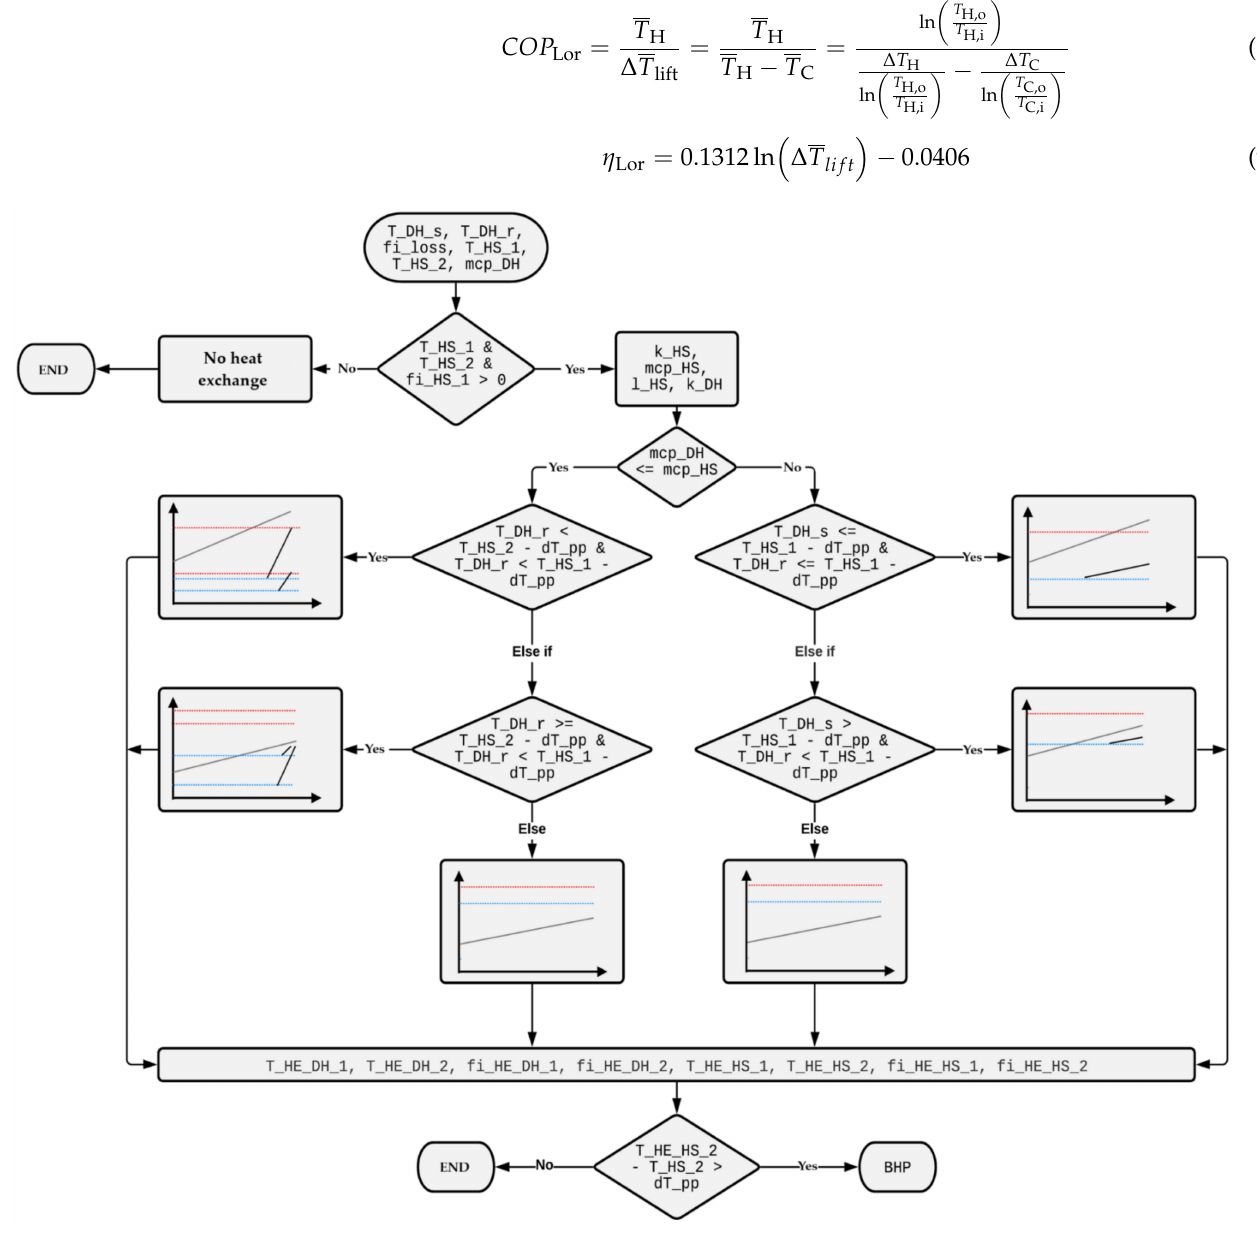
Figure 8. Overview of the pinch analysis procedure. Table 1. Labels in Figure